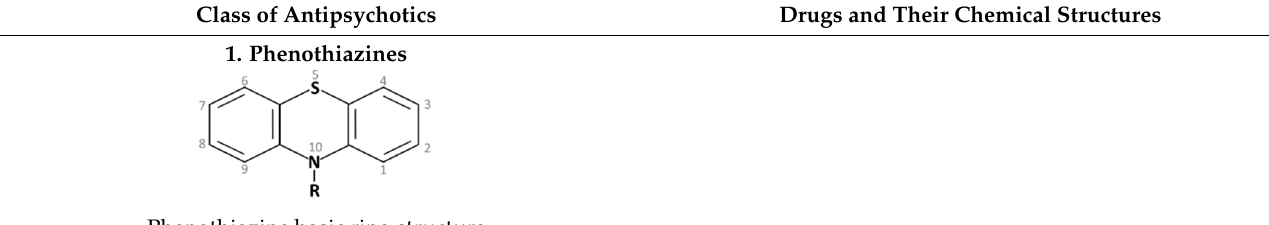
Table 1. Chemical classification of antipsychotic drugs.